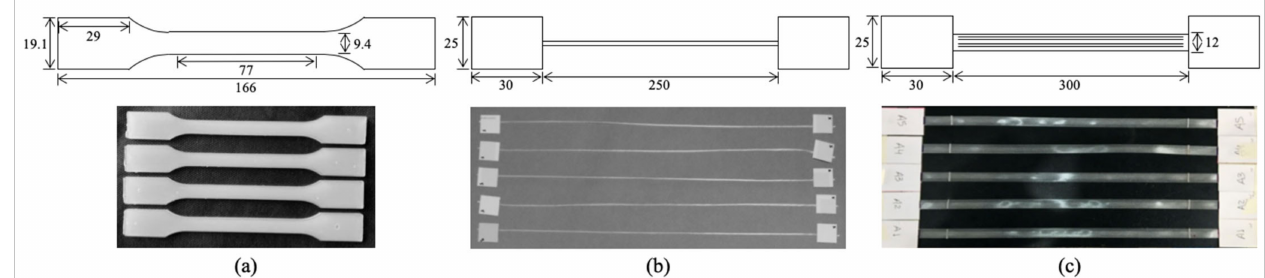
Figure 1. ( a ) LDPE, ( b ) UHMWPE, and ( c ) composite tape specimens in detail. Dimensions in millimeters (not to